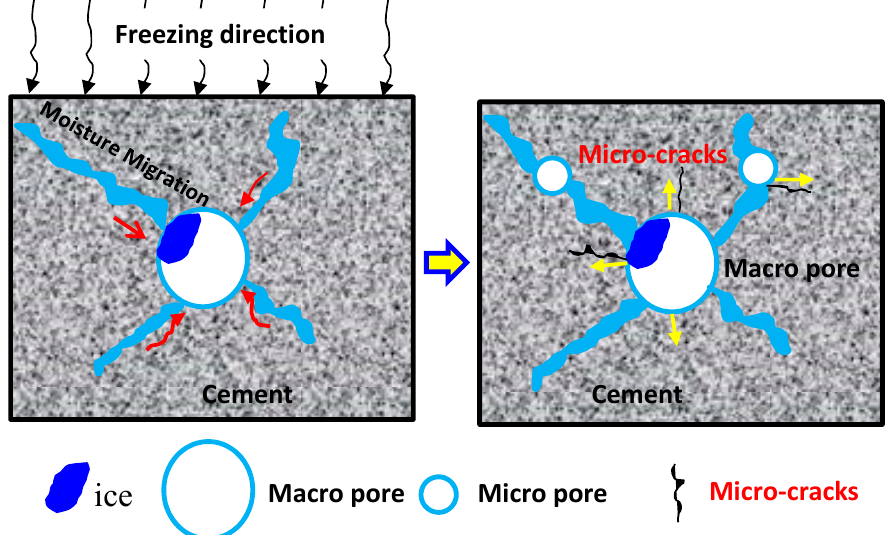
Figure 22. Schematic diagram of moisture migration in different sized pores during freezing.